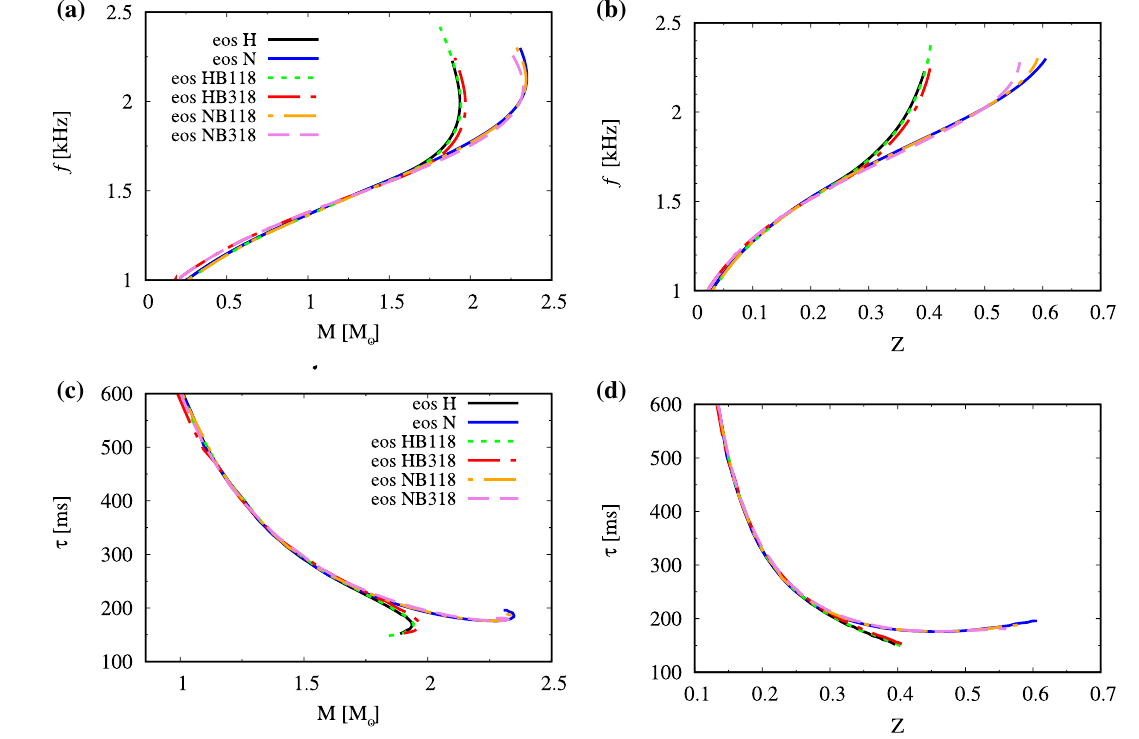
Fig. 4 Top figures: Fundamental mode frequency as a function of a the stellar mass and b of the redshift. Bottom figures: Damping time c as a function of the stellar mass and d of the